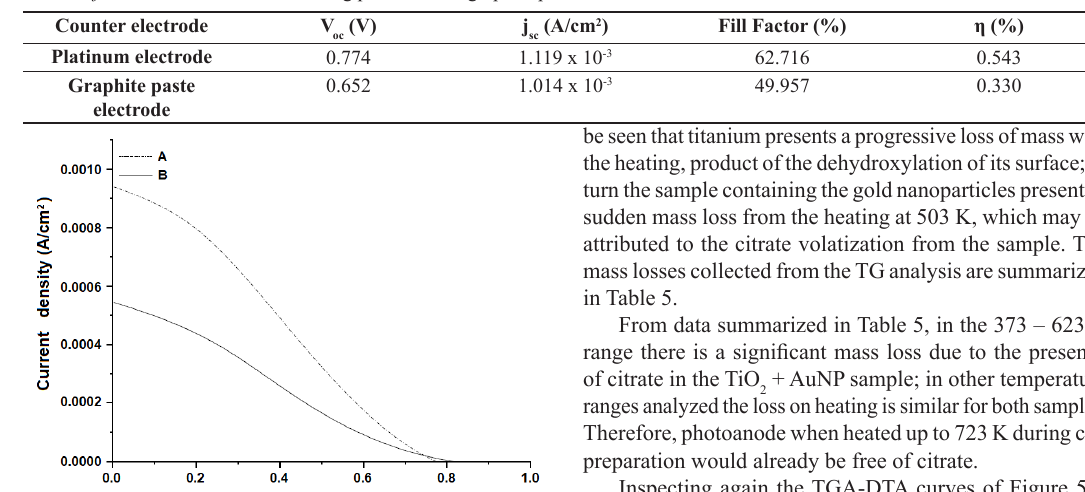
a dense microstructure of a 10μm thick film. Figure 5 right image shows the visualization via backscattered electrons of TiO film with gold nanoparticles on the surface, deposited 2 via wet impregnation method. Gold is visualized as brilliant spots, appearing as agglomerates after heating.